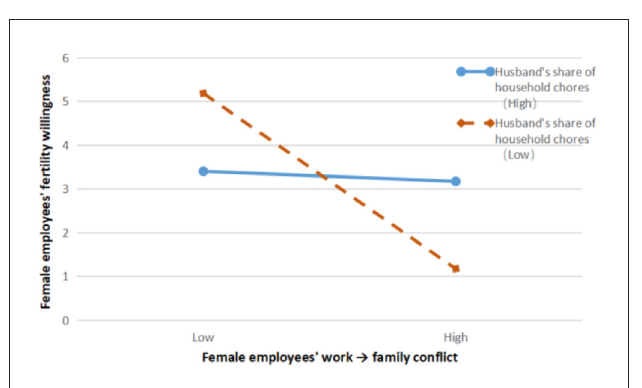
FIGURE3 Moderating effect of husband’s share of housework on the relationship between family → work conflict and fertility intention of female